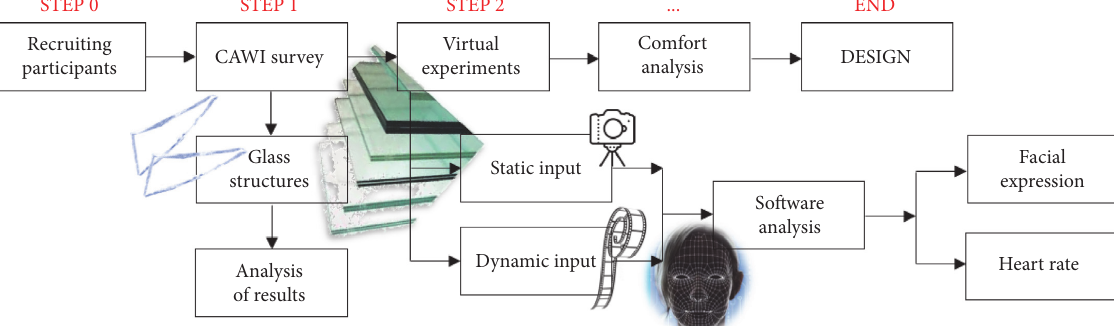
Figure 3: Flowchart of the virtual experimental analysis.